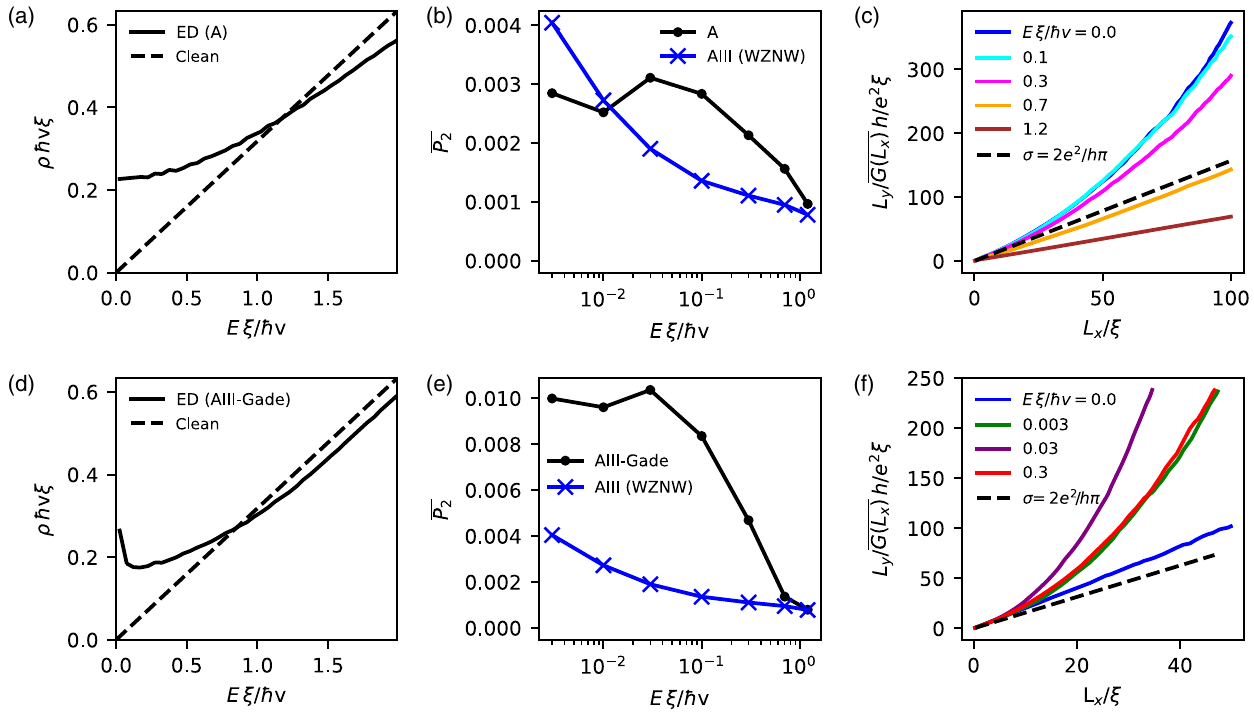
FIG. 7. Numerical results for nontopological, two-node Dirac models. Panels (a) – (c) show results for the unitary class A model defined by all 16 disorder potentials in Eq. (2). Panels (d) – (f) show results for the Gade-Dirac class AIII model defined by restricting to the 8 potentials allowed by the sublattice symmetry in Eq. (3c). In both cases, all disorder strengths are set equal to W ¼ 1 . 5 . The DOS versus energy is shown in (a) and (d), respectively. Panels (b) and (e) depict the IPR and compare to the results for the topological class AIII model from Sec. IV and Fig. 4. The data are averaged over 100 disorder realizations. Quantum transport results showing the resistance versus sample length are depicted in (c) and (f). The data are averaged over 200 disorder